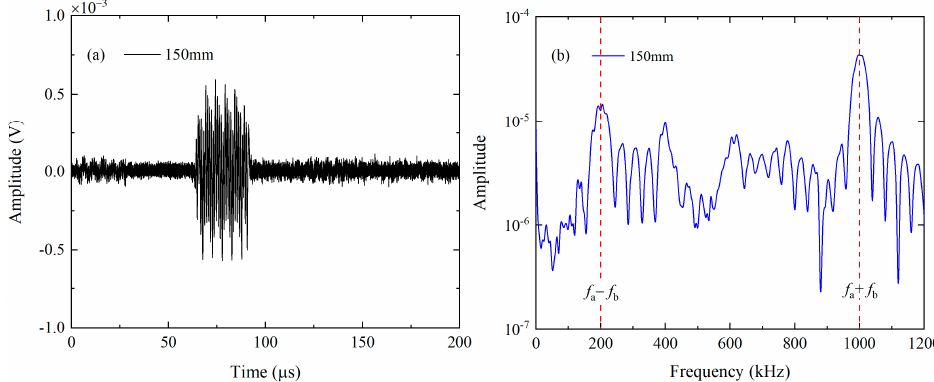
Figure 9. For the first mode triplet, four time-domain signals at 150 mm are processed by the pulse-inversion technique ( a ) and FFT ( b ).